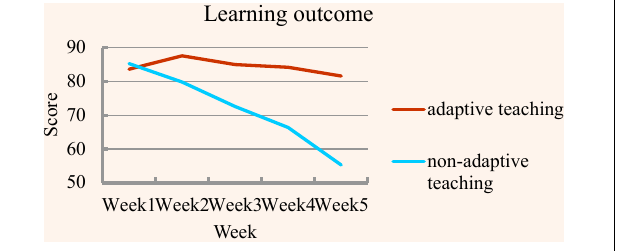
FIGURE 1 | Experimental procedure flow chart.